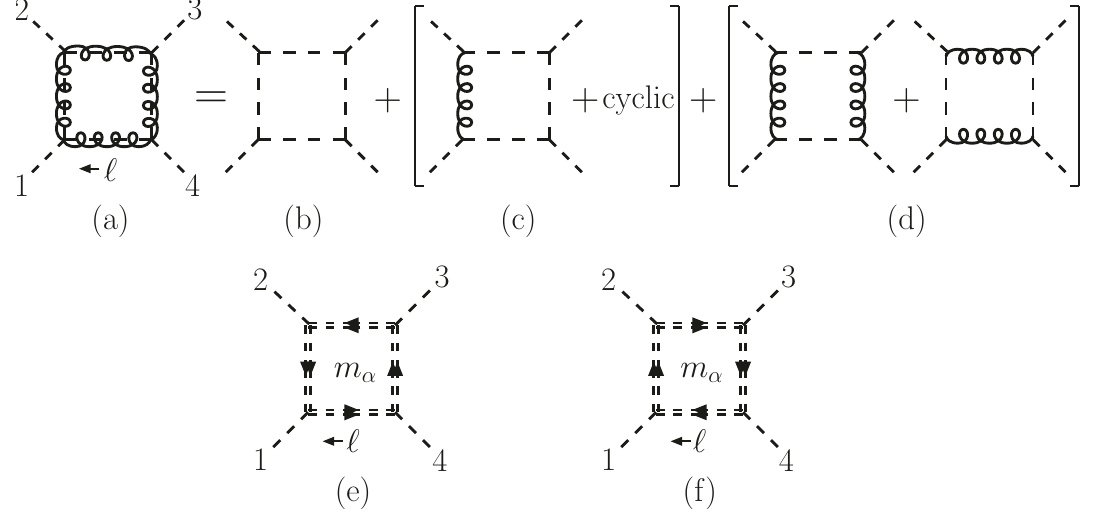
Figure 6 . The di(cid:11)erent types of box diagrams that contribute to the one-loop amplitude with four massless scalars in explicitly broken YM + (cid:30) 3 theory. Diagram (a) denotes the sum of all box diagrams with massless internal states; the contribution (b) is of order (cid:21) 4 , (c) is of order (cid:21) 2 , and (d) is of order (cid:21) 0 . Additionally, there are two conjugate diagrams (e), (f) with internal scalars of mass m (cid:11) . Dashed lines denote scalar (cid:12)elds, double lines of these corresponds to massive scalars, while curly lines denote vector (cid:12)elds. Note that quartic-scalar interactions are implicitly included in these diagrams, according to their power in the (cid:21)